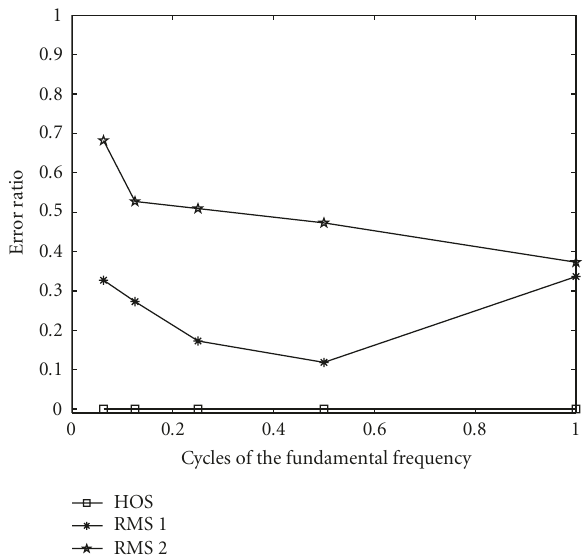
Figure 11: Error detection rate when the measurement data from IEEE working group P1159.3 is considered. The frame lengths are equal to 1/16, 1/8, 1/4, 1/2, and 1 cycles of the fundamental compo- nent and the SNR is around 40dB.